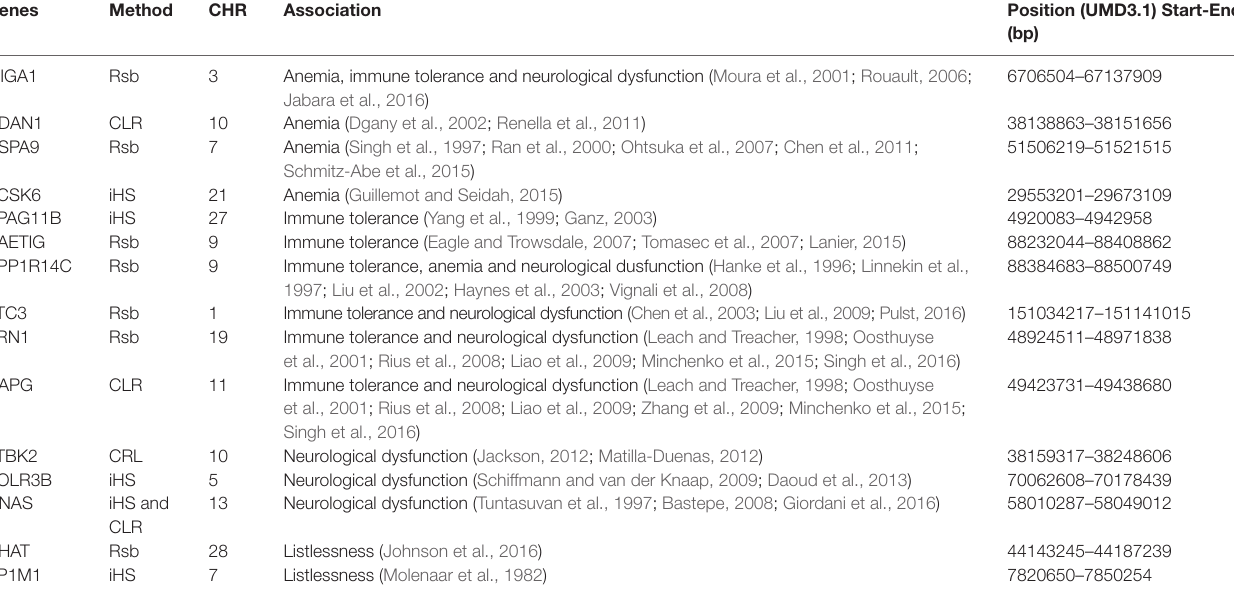
TABle 1 | Summary of major candidate signature regions identified by CLR, iHS , and Rsb analyses.